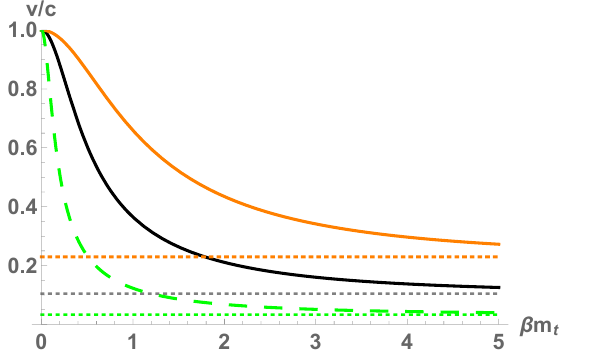
Figure 11 . The bubble Lorentz factor γ ( v ) for the standard model as a function of the top mass m t /T for ∆ P = − 0 . 01 /β 4 (green dashed), ∆ P = − 0 . 1 /β 4 (solid black) and ∆ P = − 0 . 5 /β 4 (solid orange).